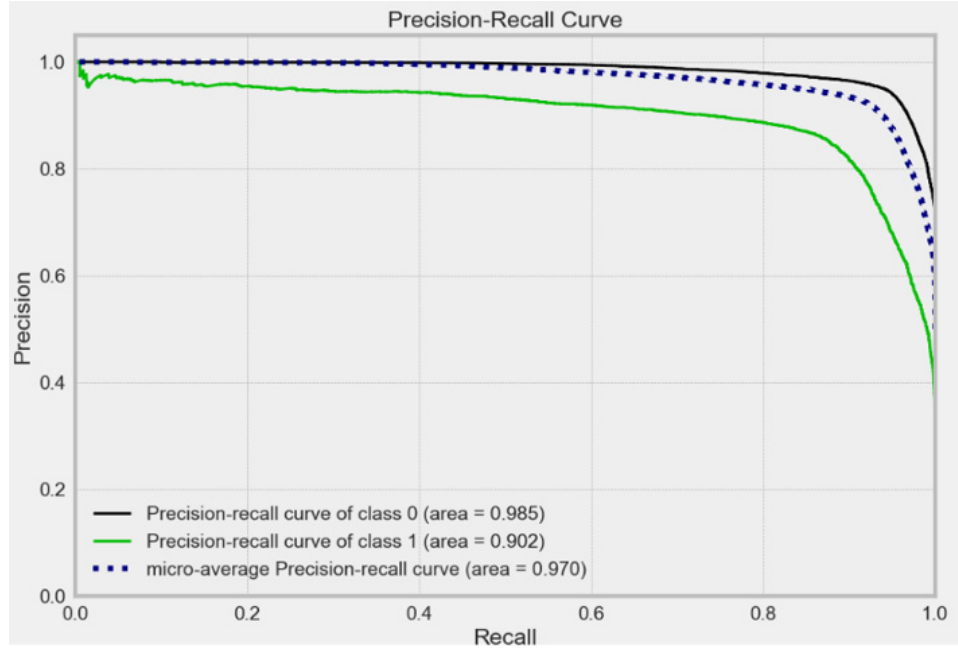
Figure 13. ROC Curves for LightGBM model.